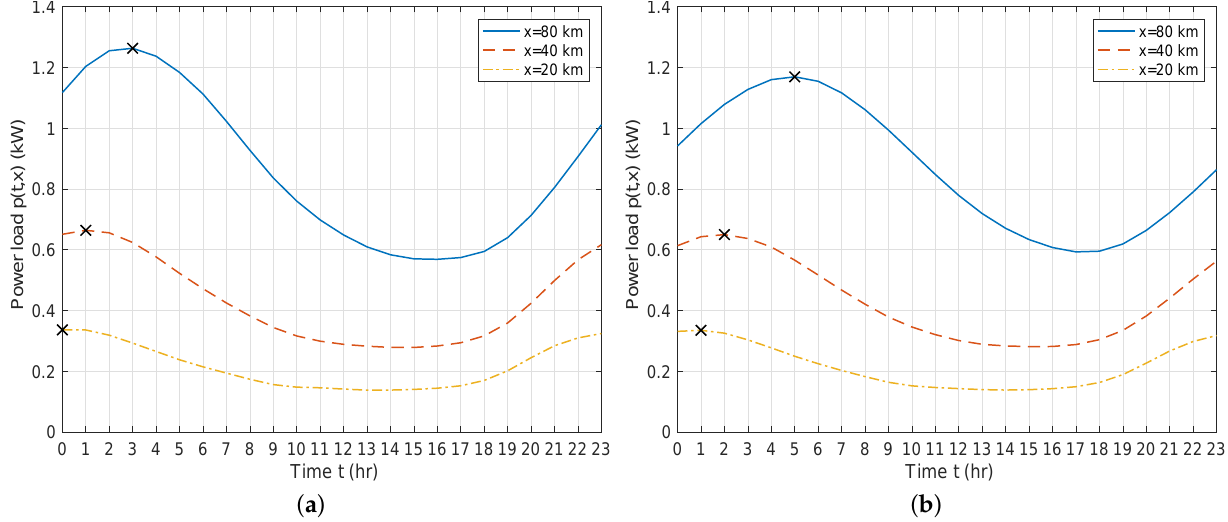
Figure 8. Power load curves p ( t , x ) for each time interval of Table 8 with the lower mean fuel efficiency of α = 4.04 km/kWh. The charging start time distribution of Figure 5 is used and the charging efficiency is η = 0.95. ( a ) The charging power is ¯ ρ = 3 kW. The maximum power of x = 80 km is 1.26 kW at 3:00 a.m. ( b ) The charging power is ¯ ρ = 2 kW. The maximum power of x = 80 km is 1.17 kW at 5:00